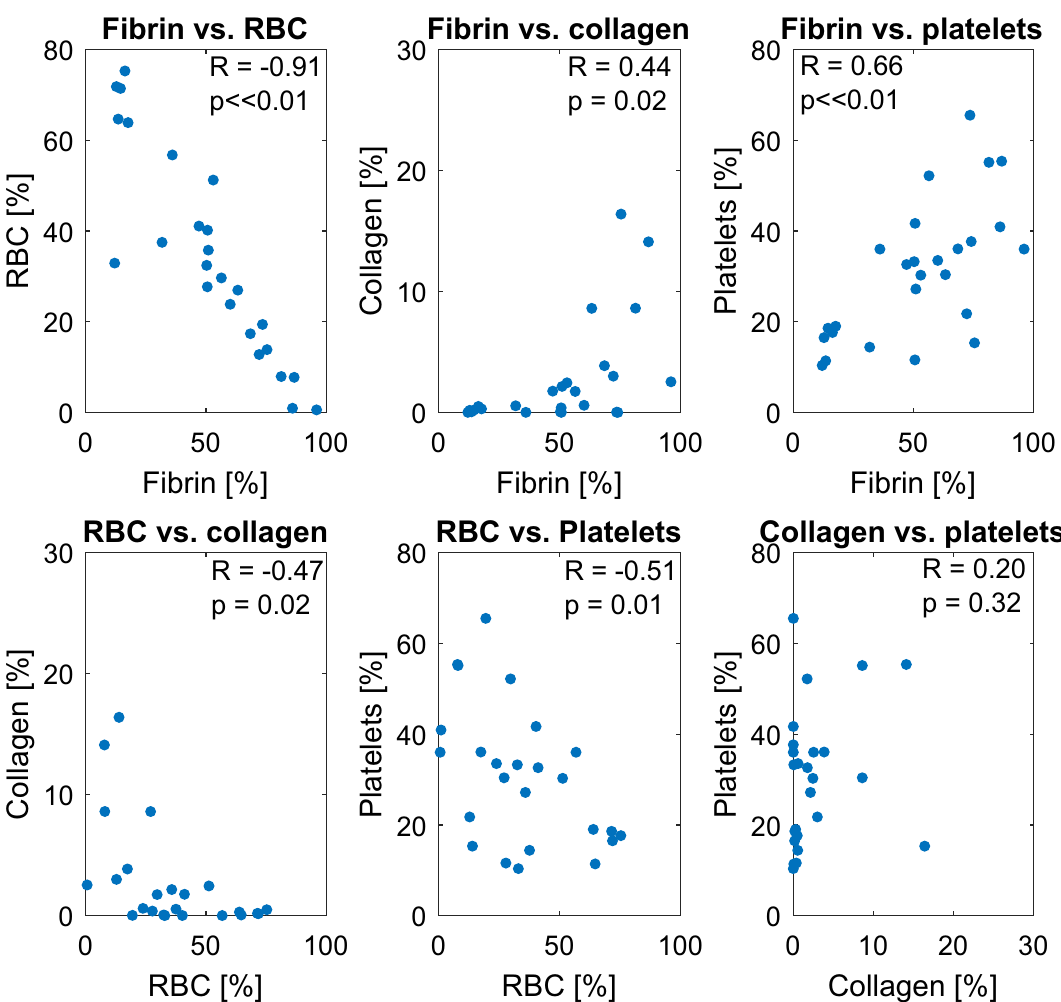
Figure 3. Trends in thrombus composition for fibrin, collagen, red blood cells (RBCs), and platelets for all samples (N = 26 total). The Pearson’s correlation coefficient (R) and p-values are reported for each respective pair.